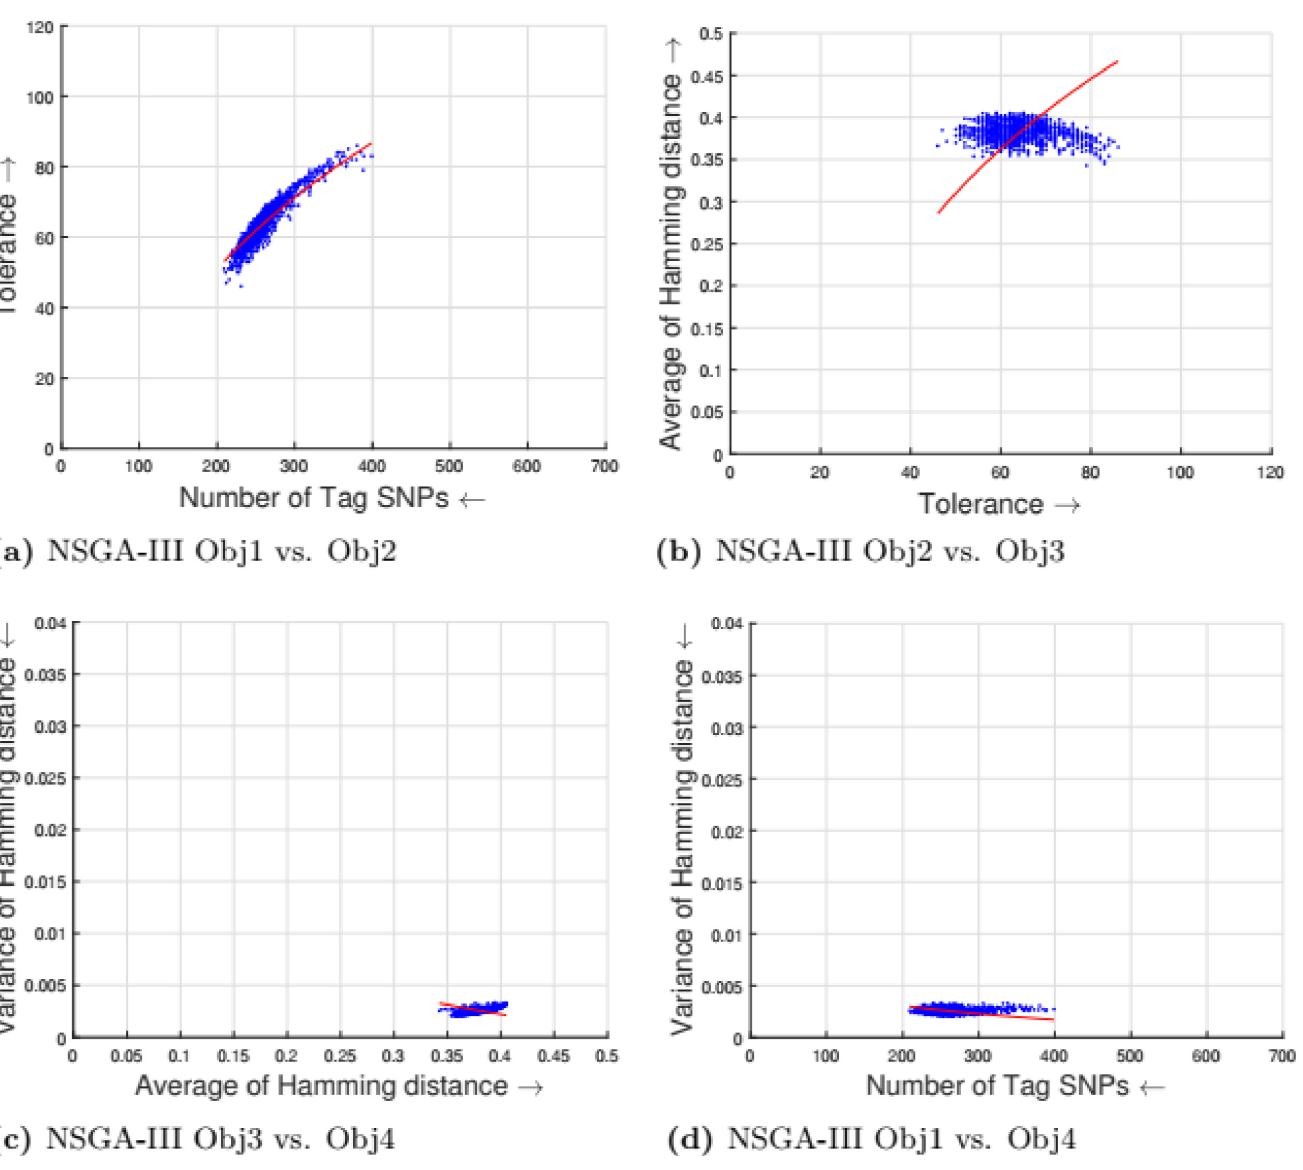
Fig 7. Experimental results of NSGA-III using greedy initialization for the tag SNPs selection problem. Obj1 stands for the number of tag SNPs, Obj2 is the tolerance for missing data, Obj3 measures the average Hamming distance between alleles, and Obj4 controls the variance of detection power in each allele. (a) NSGA-Ill Obj1 vs. Obj2, (b) NSGA-Ill Obj2 vs. Obj3, (c) NSGA-Ill Obj3 vs. Obj4, (b) NSGA-Ill Obj1 vs. Obj4.